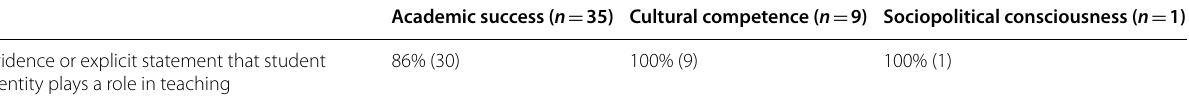
Table 4 Percentage and number (in parentheses) of instructors who expressed student identity played a role in their teaching, out of the instructors who expressed enacting each of the three